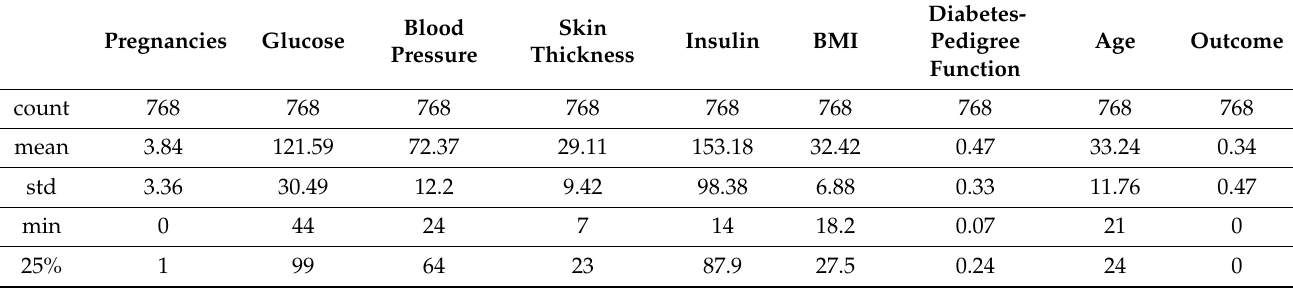
Table 2. Statistical description of the Pima Indian Diabetes dataset.